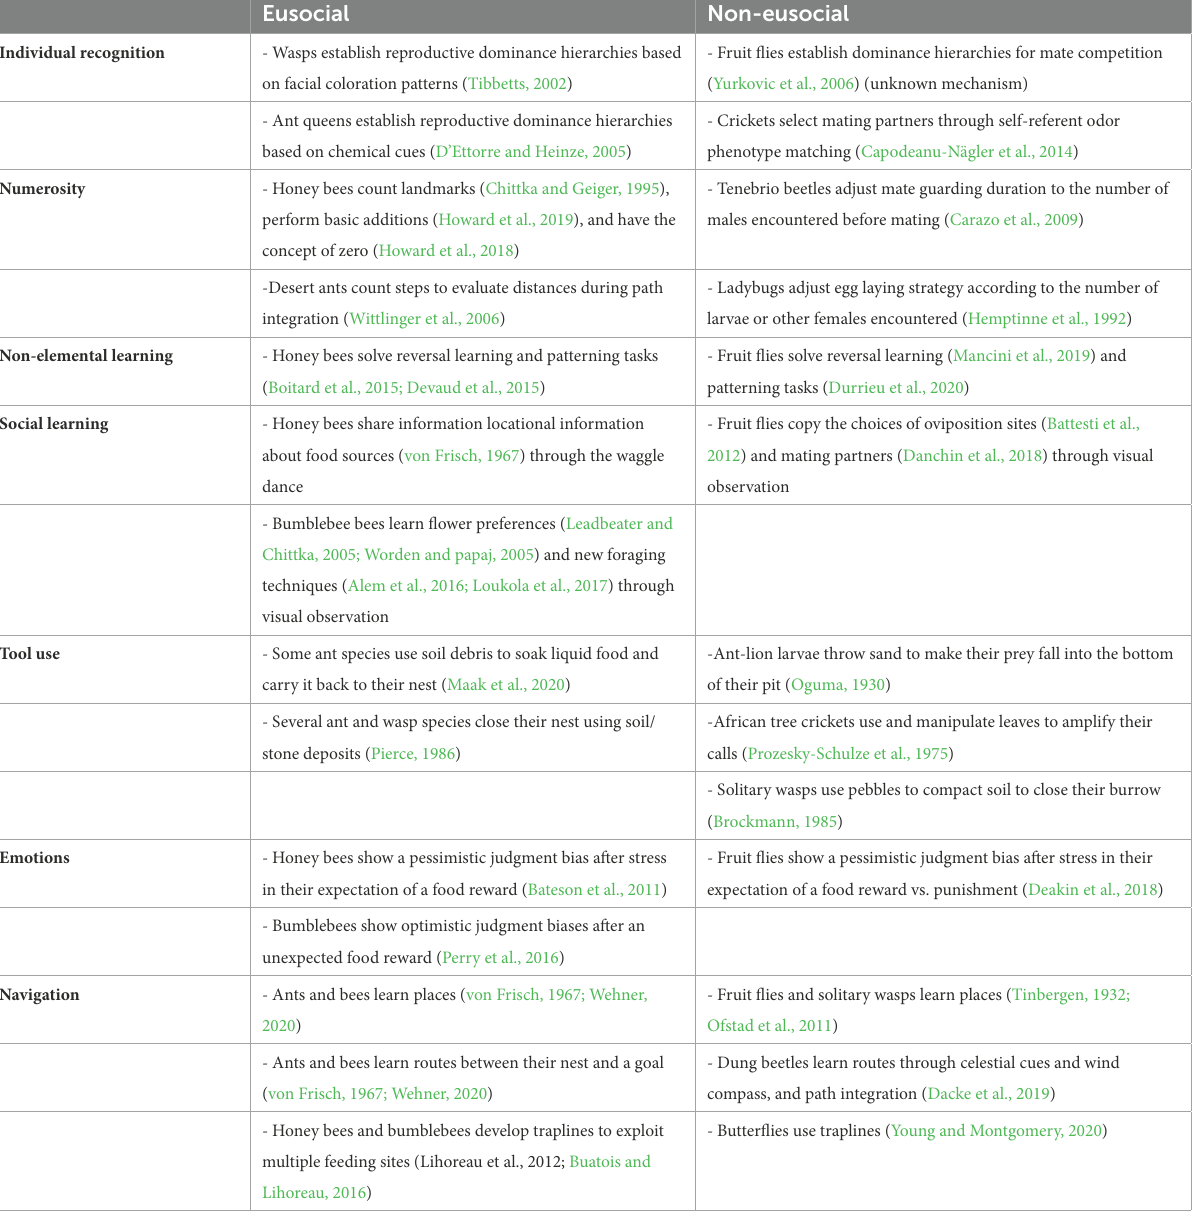
TABLE 1 Some examples of cognitive abilities reported in eusocial and non-eusocial insect